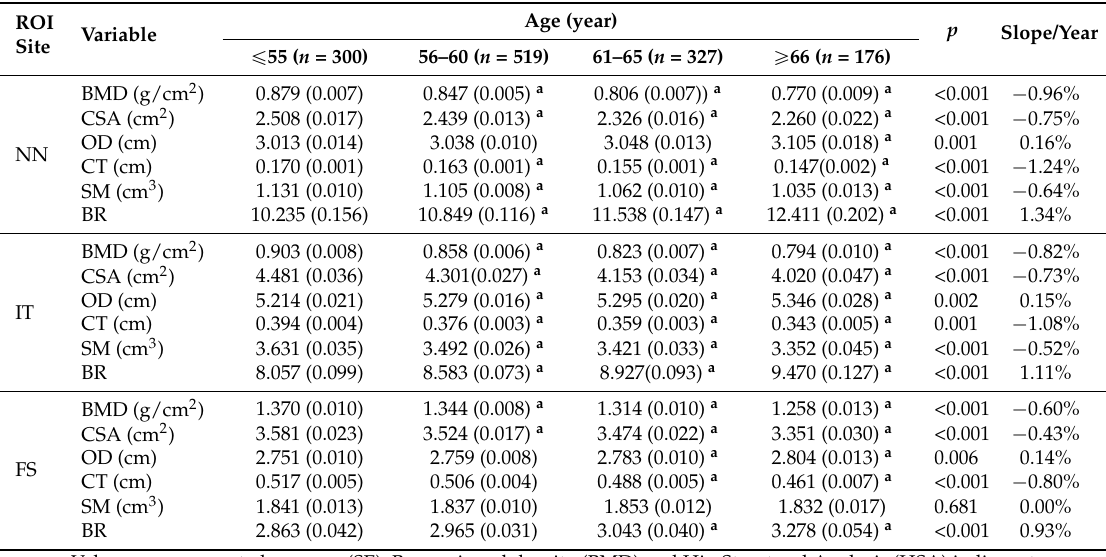
Table 3. BMD and HSA indices of subjects in different age